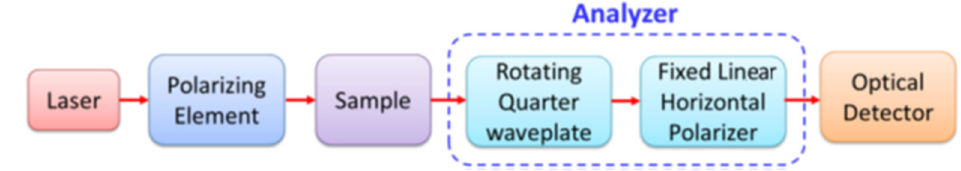
Figure 3. Rotating quarter waveplate method for measuring Stokes parameters [20].